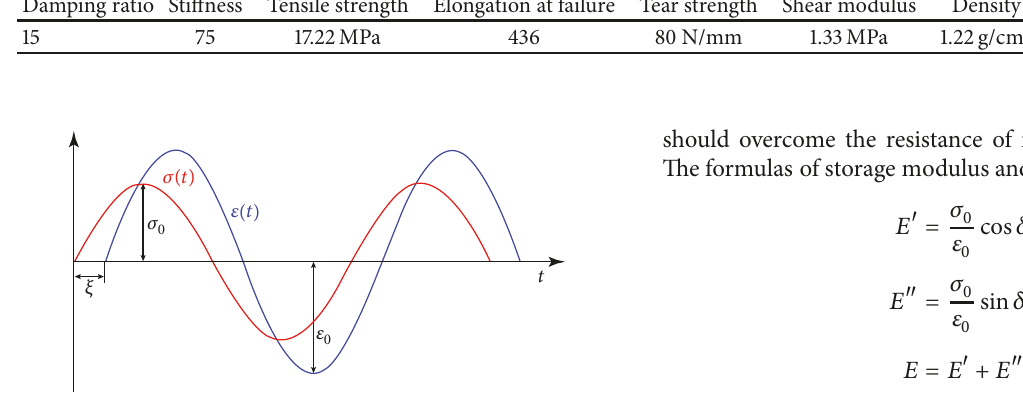
Figure 2: Response of sinusoidal stress and strain in high-damping rubber. −+ O− +